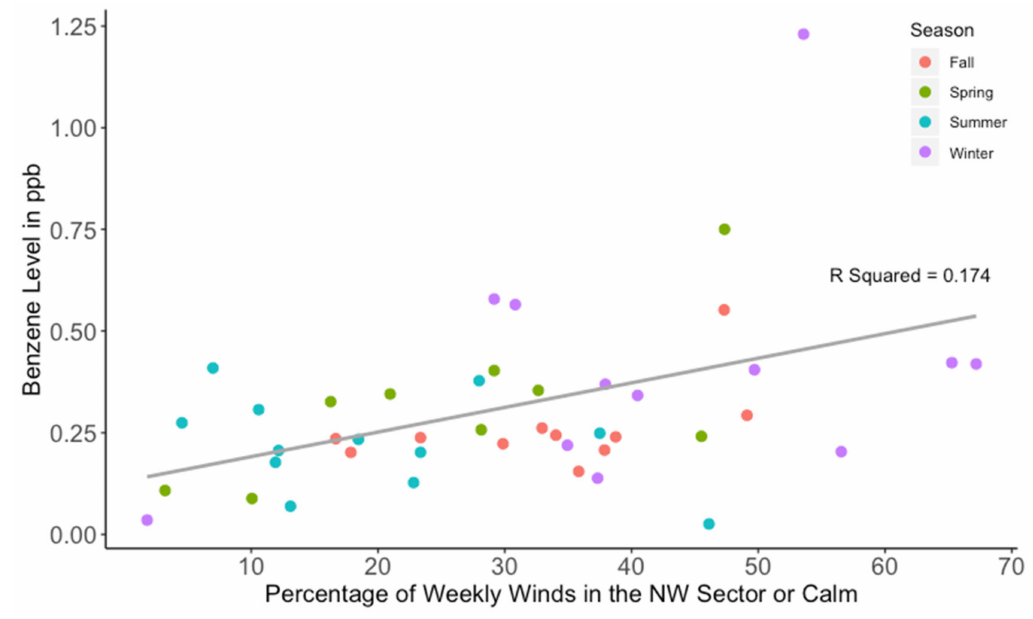
Figure 6. Relationship between the percentage of hourly winds traveling over the site toward the monitoring station and benzene levels. As the amount of transport from the site increased, levels of benzene became higher ( p = 0.005). Colors correspond to the 3-month season the sample was taken